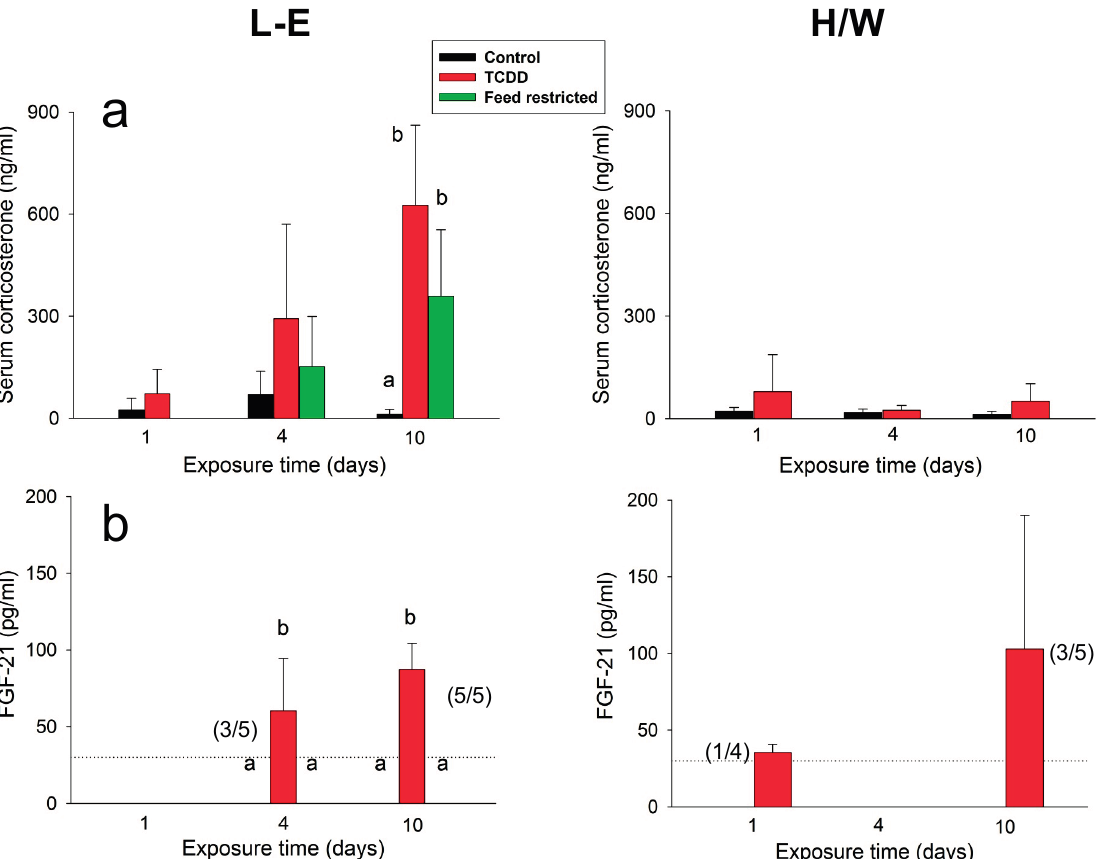
Figure 5. The effect of TCDD or feed restriction on ( a ) serum corticosterone and ( b ) FGF-21 concentrations in L-E ( left panel) and H/W rats ( right panel) as a function of time (mean ± SD). In ( b ) the FGF-21 assay detection limit, corresponding to a serum concentration of 30 pg/mL, is depicted with a horizontal dotted line. The number of animals exceeding the limit per total group size (4–5) is given in parenthesis. For those groups not shown in the graph, all values fell below the detection limit. The height of the bar depicts the mean of all animals in the group. The means and SDs are calculated by setting the below threshold values to 30 pg/mL. Otherwise, the conditions are as in Figure